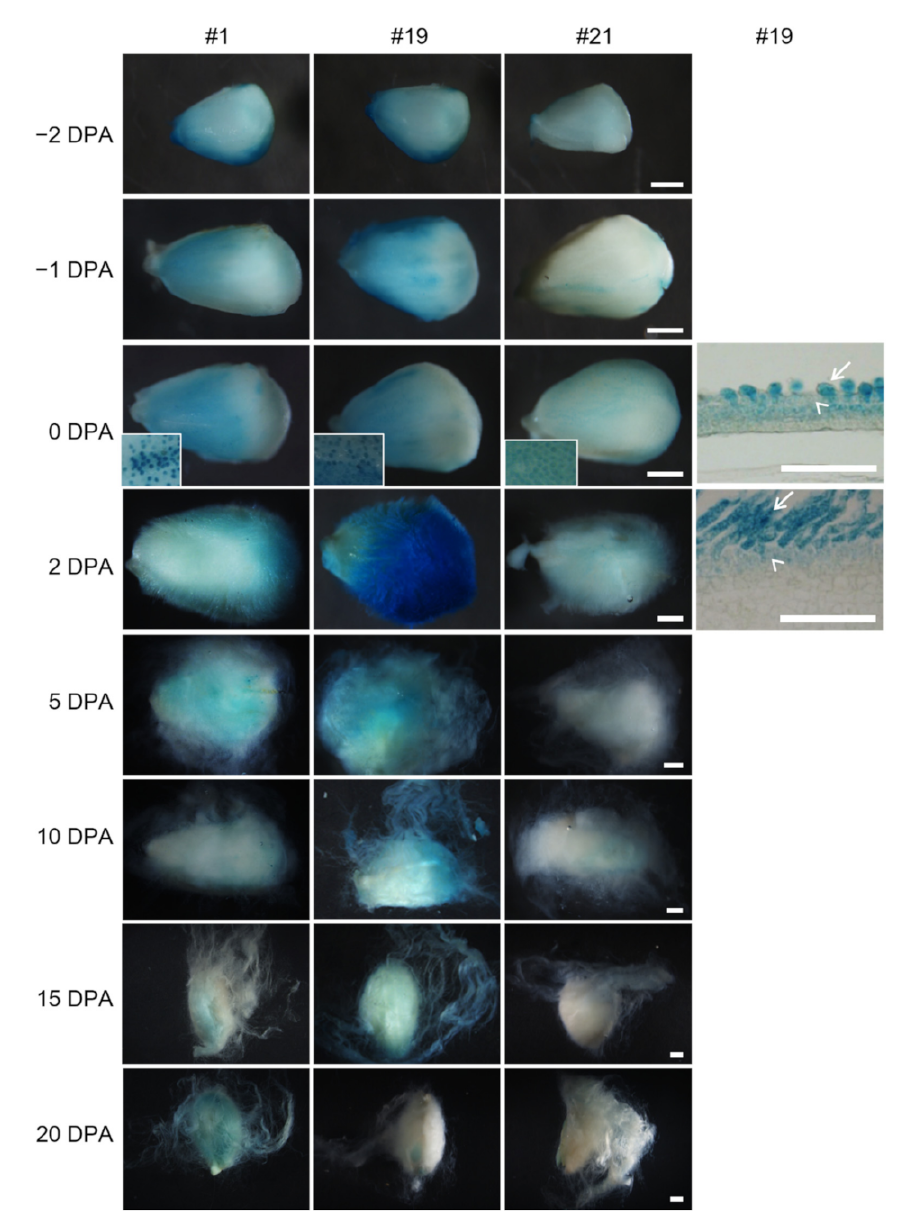
Figure 4. GUS activity in developing ovules of proGhRop6::GUS transgenic cotton. Gus staining in ovules of transformant #19 were further observed through paraffin-embedded sections. Arrows indicate fiber cells, and arrowheads indicate non-fiber cells in ovule epidermis. Scale bars represent 500 µ m (ovule images) or 50 µ m